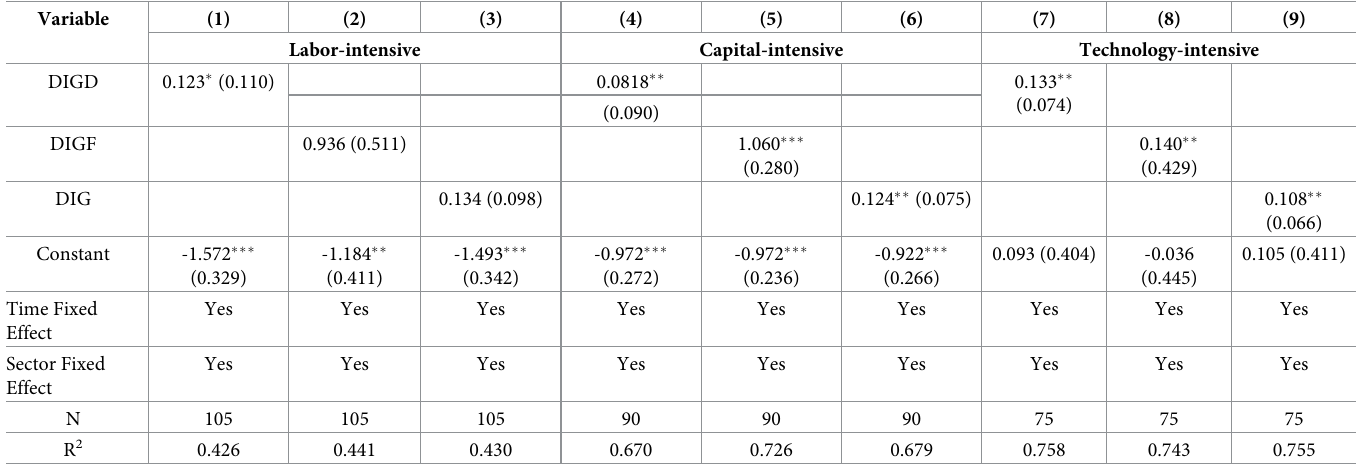
Table 6. Factor density heterogeneity